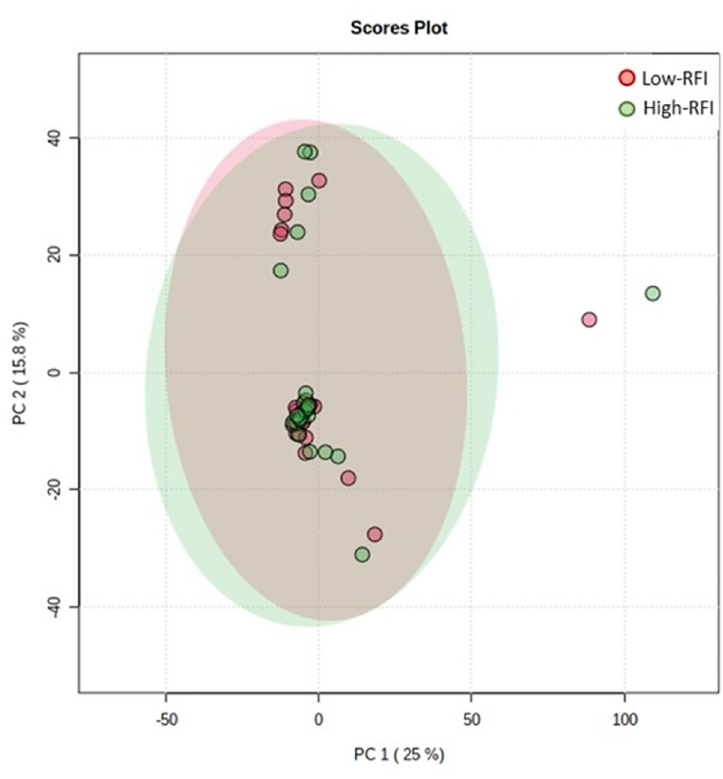
Fig 1. Principal component analysis plot score according to residual feed intake class (Low vs. High RFI) of Charolais heifers.